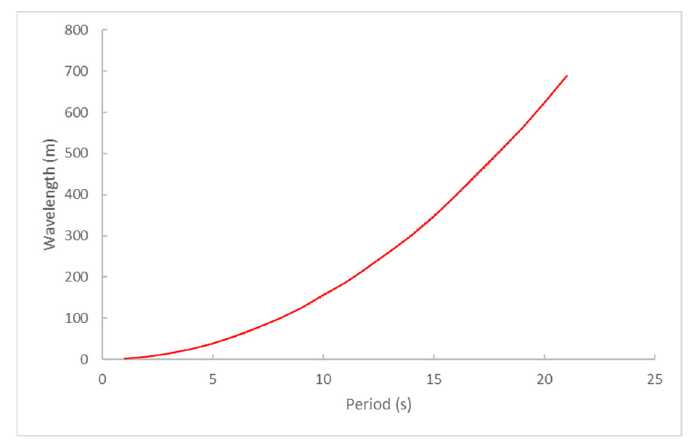
Figure 1. Representation of wavelength as a function of